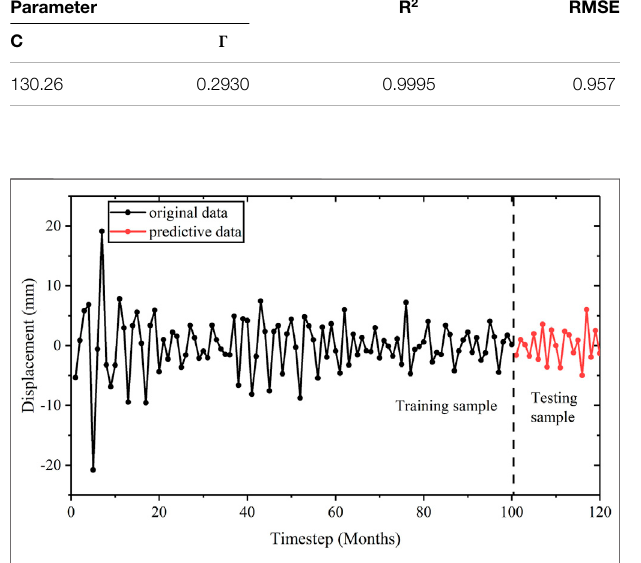
FIGURE 9 | Plot highlighting the prediction of random displacement.